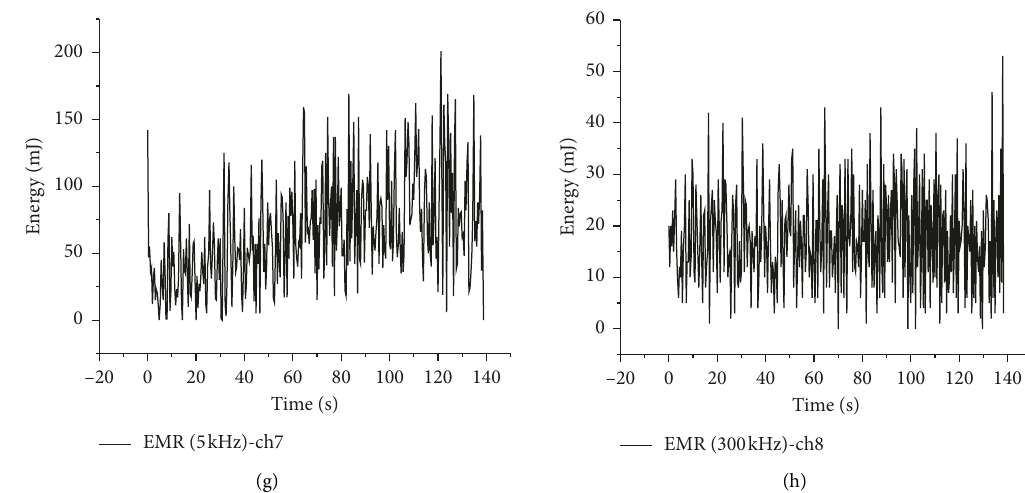
Figure 5: Electric-magnetic-acoustic signals of 2# rock sample (1 mm/min). (a) Stress-time. Electric signals of (b) ch2, (c) ch8, and (d) ch9. (e) Acoustic emission signals. Magnetic signals of (f) ch5, (g) ch7, and (h) ch8.